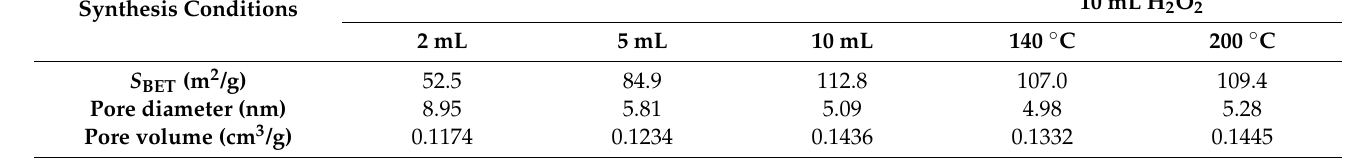
Different Temperaments with 10 mL H 2 O